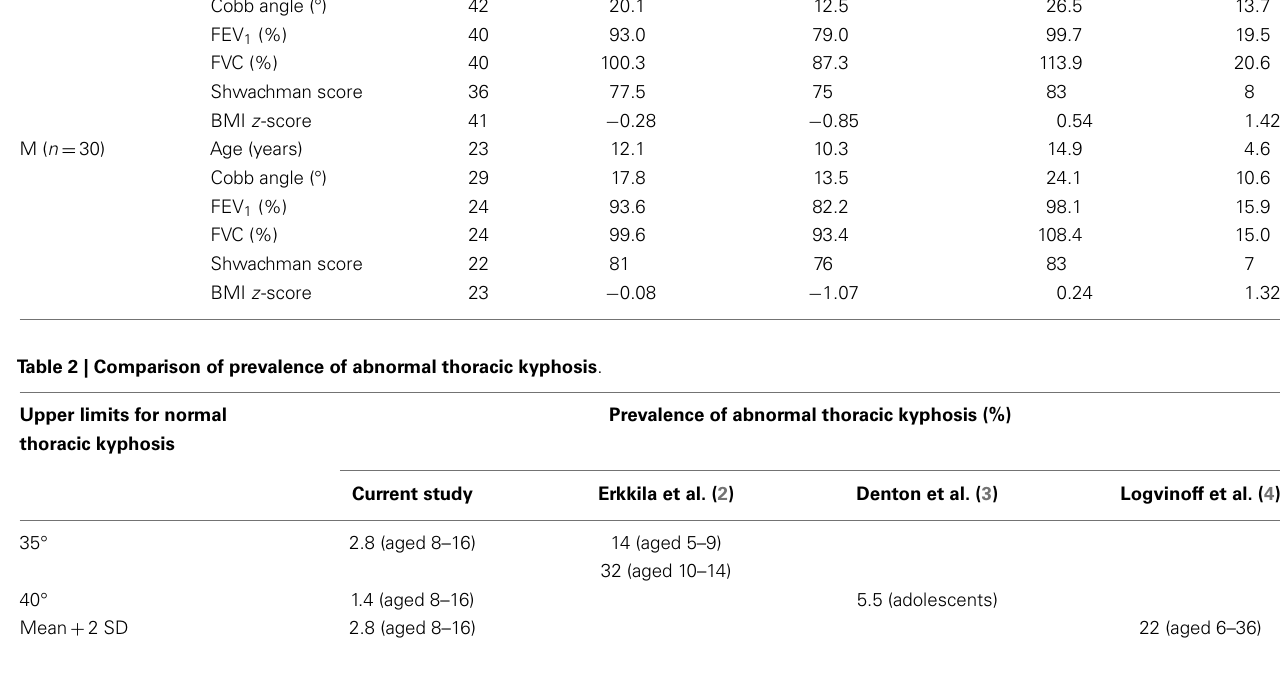
Table 1 | Summary of data subdivided by gender .